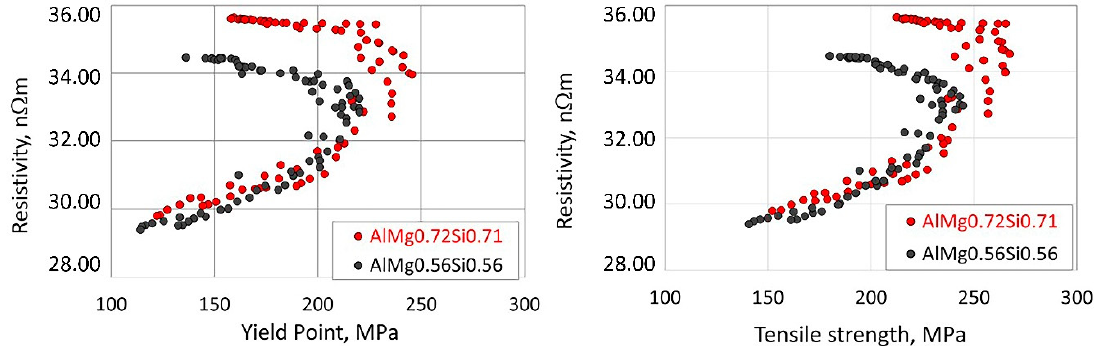
Figure 8. Relationship between the yield point and resistivity and between the tensile strength and resistivity of Al-Mg-Si wire rods after artificial aging (black points: AlMg0.56Si0.56, red dots: AlMg0.72Si0.71).